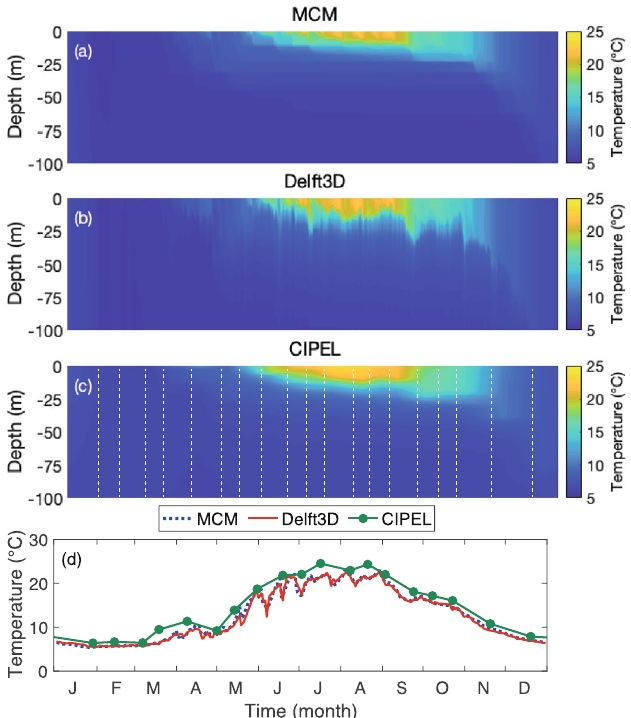
Figure 4. Evolution of the water temperature at 1100 UTC at station SHL2. ( a – c ) Vertical profiles from ( a ) the MCM, ( b ) Delft3D, and ( c ) CIPEL measurements. ( d ) Bulk surface temperature. Plots generated with Matlab 25 ; Panels assembled with Adobe Illustrator 26